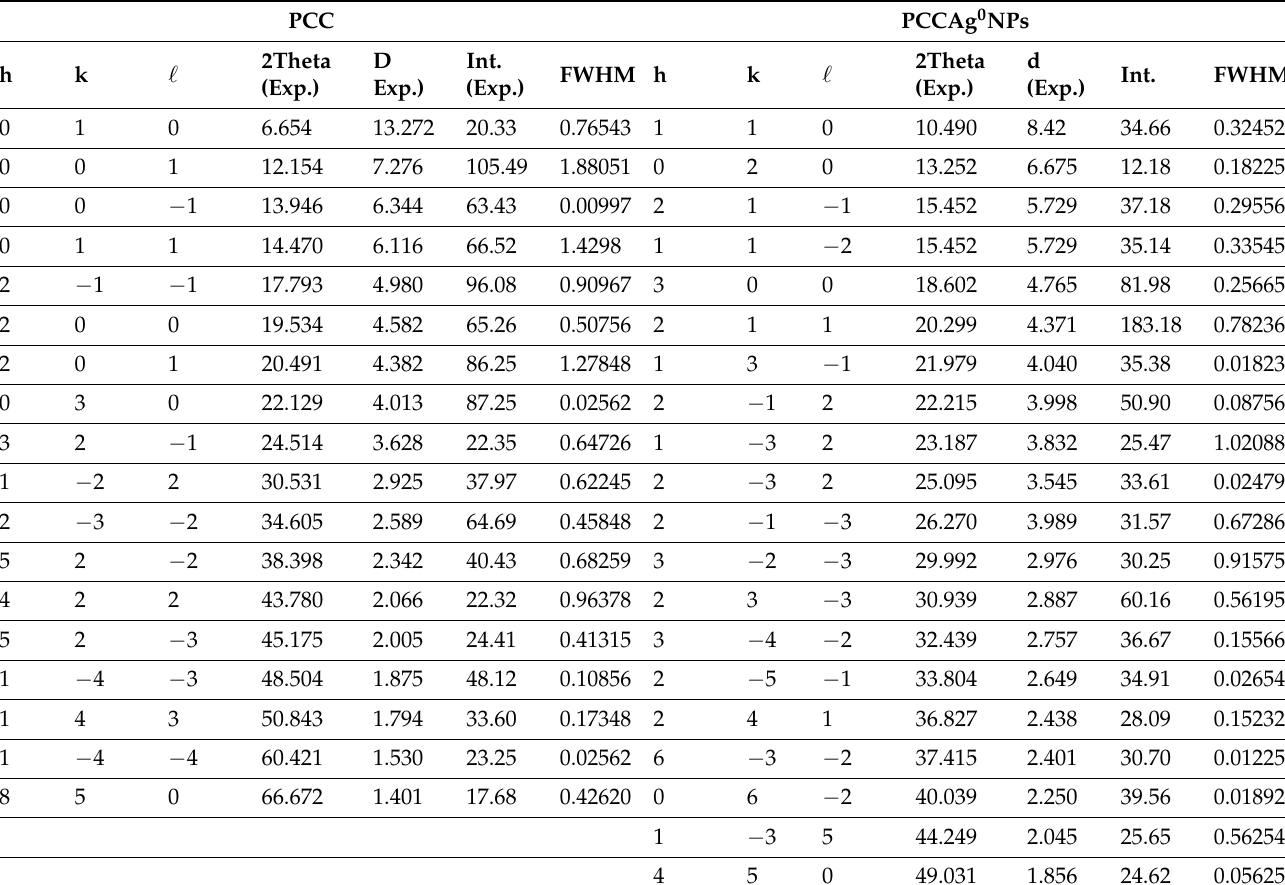
Figure 7 showed the refined bond distance in PCC and PCCAg 0 NPs.